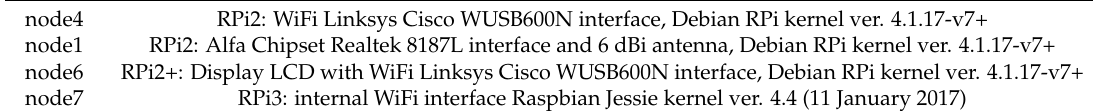
Figure 12. Relationship between R(t) and node proximity to the centre in a 3 × 3 PWMNS.